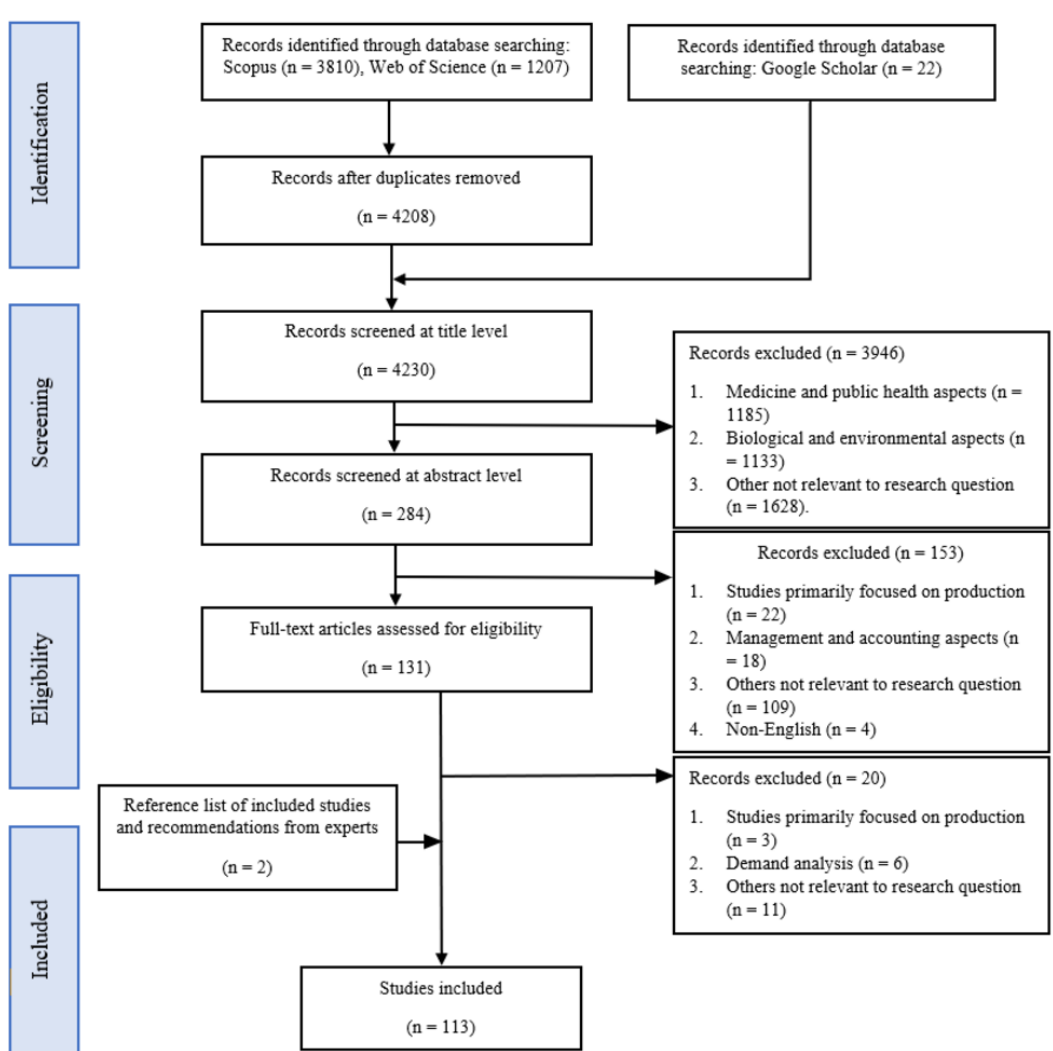
Figure 1. PRISMA–ScR flow diagram indicating the selection process of